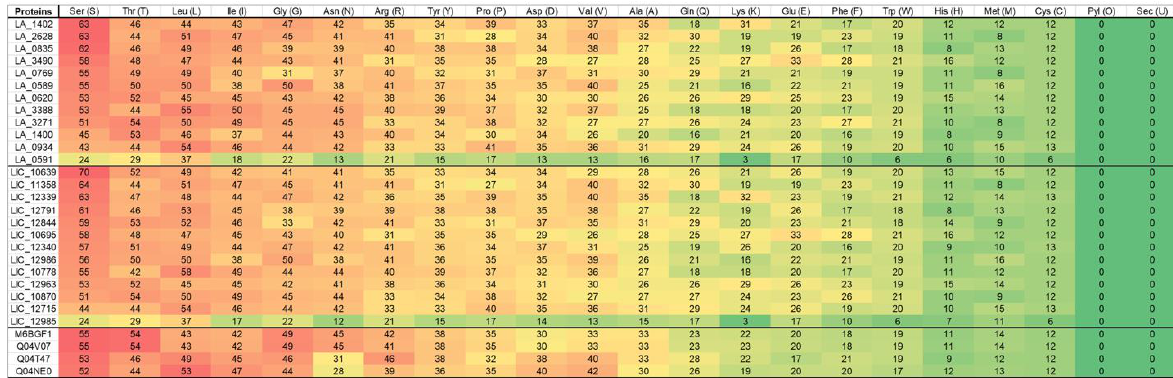
Figure 3. Comparative amino acids conservation from L. interrogans Lai, L. interrogans Copenhageni (LIC), and L. borgpeterseni . The prediction of amino acid conservation across the spp. among the paralogs was performed using Expasy ProtParam tool [49] . Legend: Redder, the bigger the amount of that amino acid at the VM protein sequence. Greener, less the amount of that particular amino acid at the VM protein sequence.